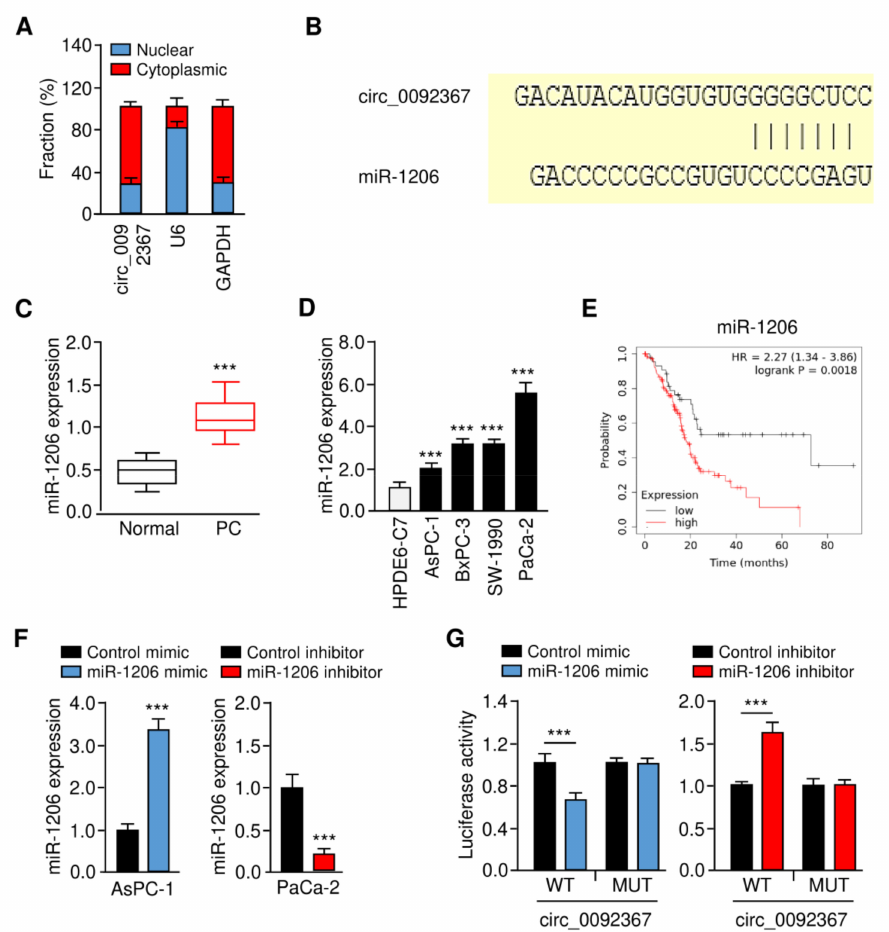
Figure 4. Circ_0092367 Serves as a MiR-1206 Sponge in PC Cells. ( A ) The subcellular location of circ_0092367 in PaCa-2 cells. ( B ) The complementary sequence between miR-1206 and circ_0092367 (CircInteractome). ( C ) MiR-1206 expression in PC tissues and adjacent normal tissues. ( D ) MiR-1206 expression in PC cells and normal cells. ( E ) Kaplan–Meier survival analysis of PC patients with lower versus higher miR-1206 expression. ( F ) MiR-1206 expression in PC cells transfected as indicated was investigated with qRT-PCR analysis. ( G ) PC cells were transfected with wild-type (WT) or mutant (MUT) circ_0092367, with miR-1206 mimic and miR-1206 inhibitor, and luciferase assays were performed. The experiments in ( A , D , F , G ) were repeated three times independently with similar results. *** p <